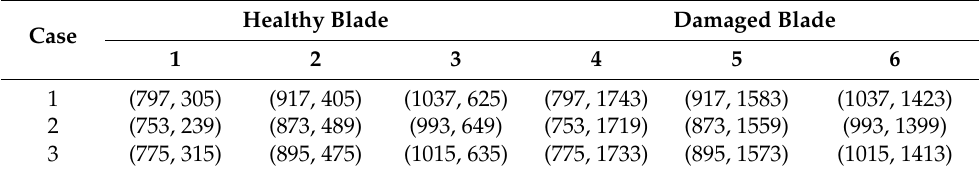
Table 2. Location of measured points of experiment 2.